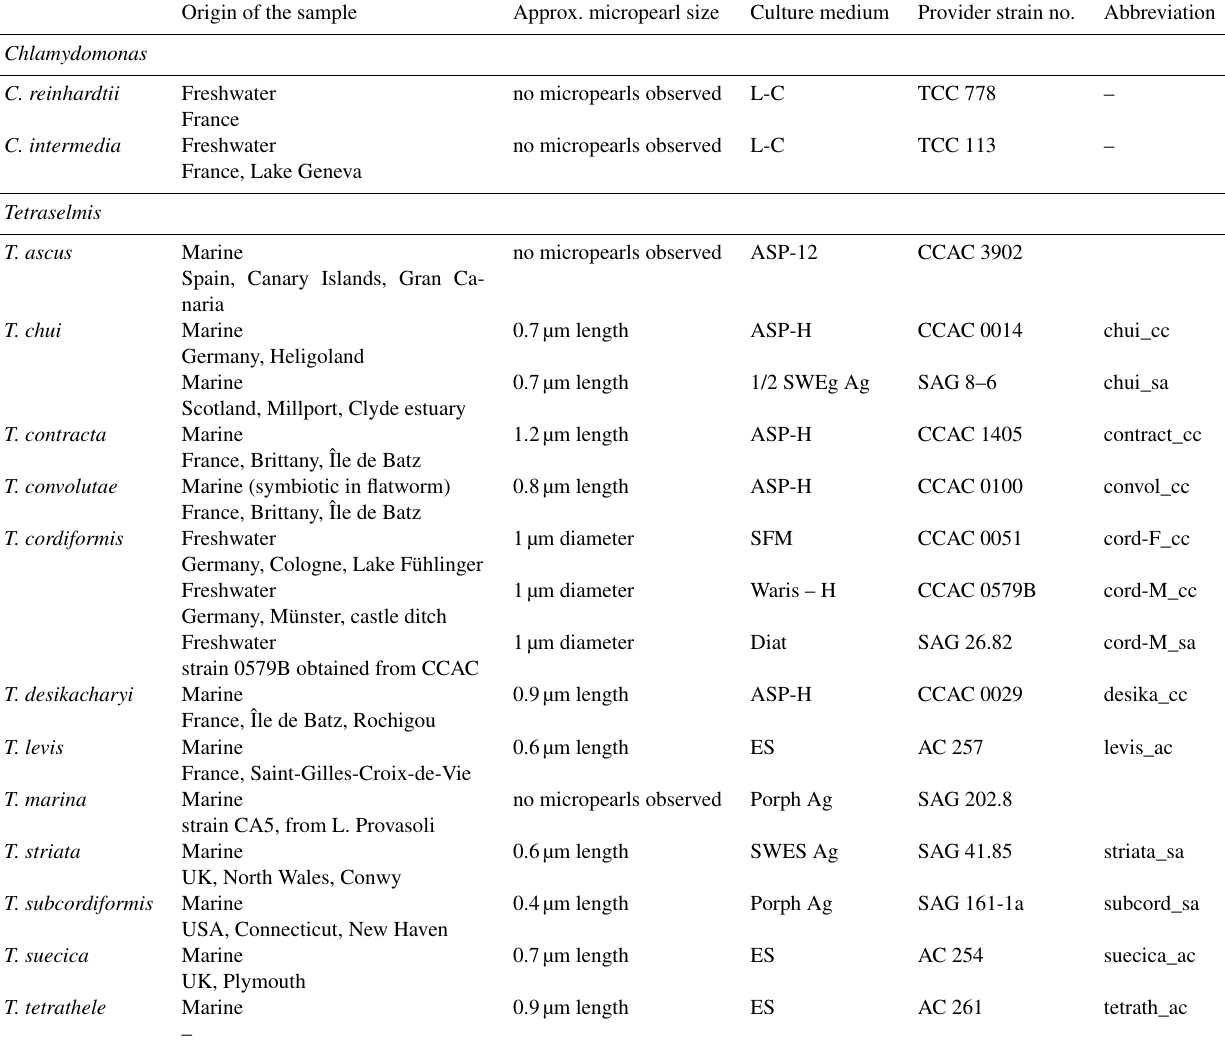
Table 1. Specific information for each species and their culture conditions. Providers include the following. CCAC: Culture Collection of Algae at the University of Cologne (Germany) – http://www.ccac.uni-koeln.de/, last access: 6 July 2018; SAG: Sammlung von Algenkulturen at the University of Göttingen (Germany) – https://www.uni-goettingen.de/de/184982.html, last access: 6 July 2018; AC: Algobank – culture collection of microalgae of the University of Caen (France) – https://www.unicaen.fr/algobank/accueil/, last access: 6 July 2018; TCC: Thonon Culture Collection of the CARRTEL of Thonon-les-Bains (France) – https://www6.inra.fr/carrtel-collection, last access: 6 July 2018. All culture media compositions are given on the corresponding websites (detailed addresses in Table